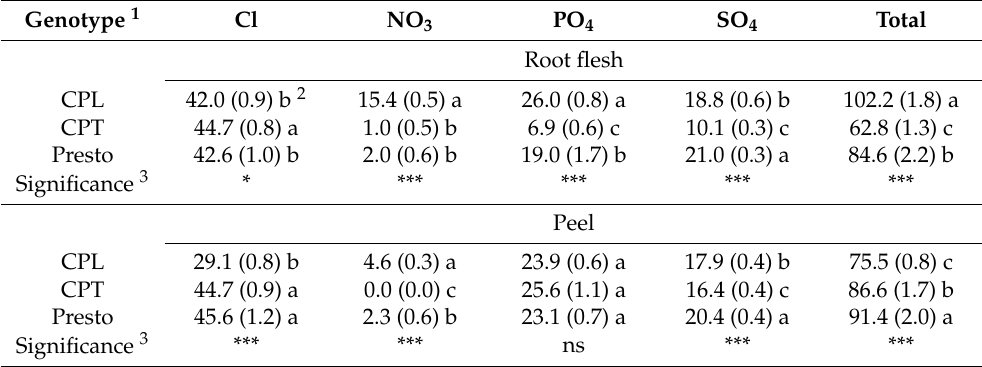
Table 3. Concentration of inorganic anions in the root flesh and peel of carrot genotypes (mg 100 g − 1